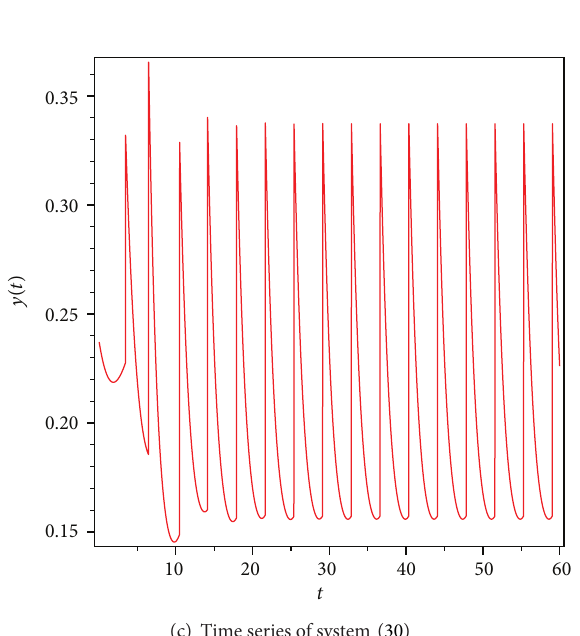
Figure 11: 1-periodic solution in the area Ω 1 = {(𝑥,𝑦) | ℎ 1 < 𝑥 < ℎ 2 } corresponding to Figure 5(d) does not